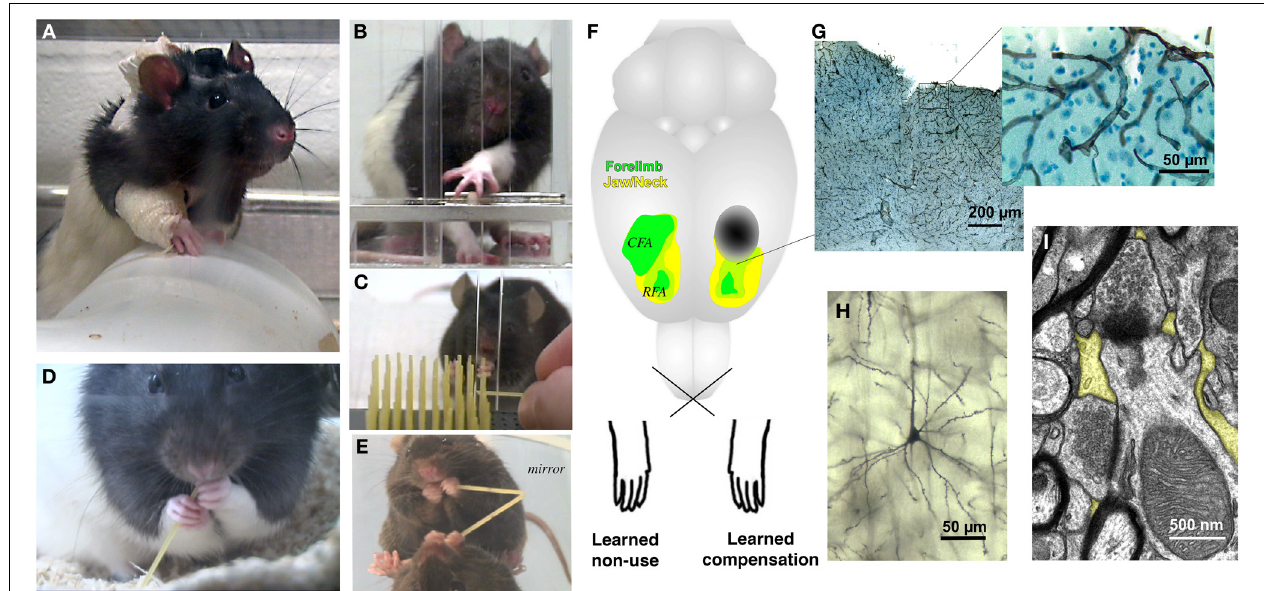
FIGURE 1 | Rodent models of upper extremity impairments after stroke used to study forelimb experience effects on brain and behavioral outcomes. Examples of behavioral manipulations in rats and mice include (A) forelimb constraint, used to force greater use of the paretic limb, (B,C) skilled reaching tasks, used to model both rehabilitative training (RT) focused on the paretic limb and compensatory skill learning with the nonparetic limb and, (D,E) pasta handling tasks, used to provide coordinated bimanual experience. (F) Approximate motor cortical infarct location (dark oval) used in several studies, as shown relative to head (yellow) and forelimb (green)